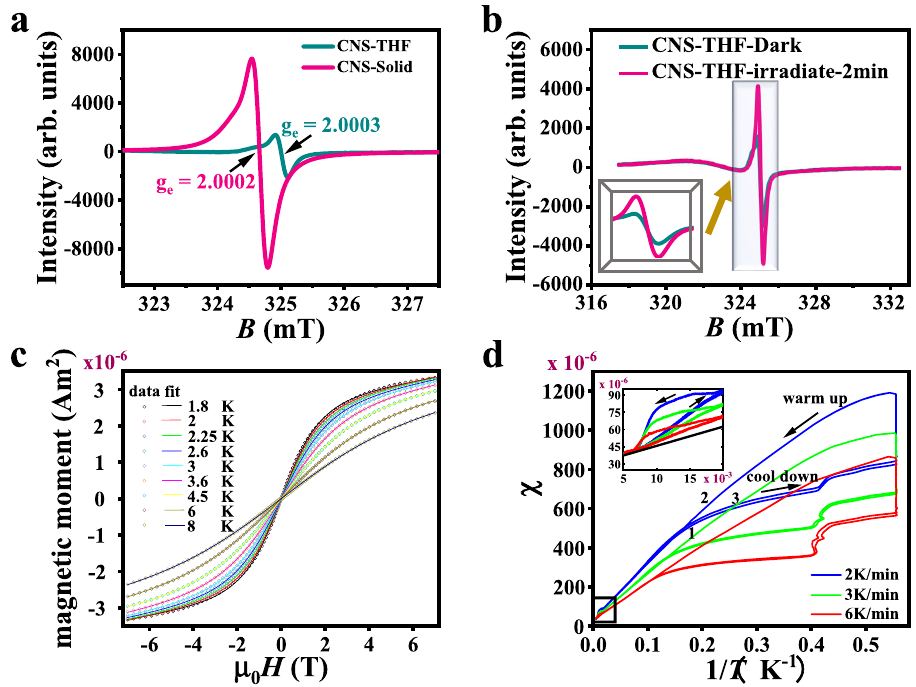
Fig. 6 Magnetic properties of CNS. a Room temperature EPR spectra of solid powder and THF solution of CNS. b EPR spectra of THF solution of CNS under dark and illumination for 2 min under 500 W xenon lamp. c, d Low temperature magnetization measurements of a CNS powder sample. c Magnetization for different temperatures (open circles, raw data) and fi t of a Brillouin function with a diamagnetic background (solid lines) ( fi eld scan rates between 1 and 10 mT/s increase linearly with the applied fi eld). d Sample susceptibility χ as obtained from the magnetic moment in 0.2 T applied fi eld and an estimated sample volume of 2 × 10 − 9 m 3 vs. Reciprocal temperature for scans from 200 K to 1.8 K cool down (1) to 200 K warm up (2) to 1.8 K cool down (3)